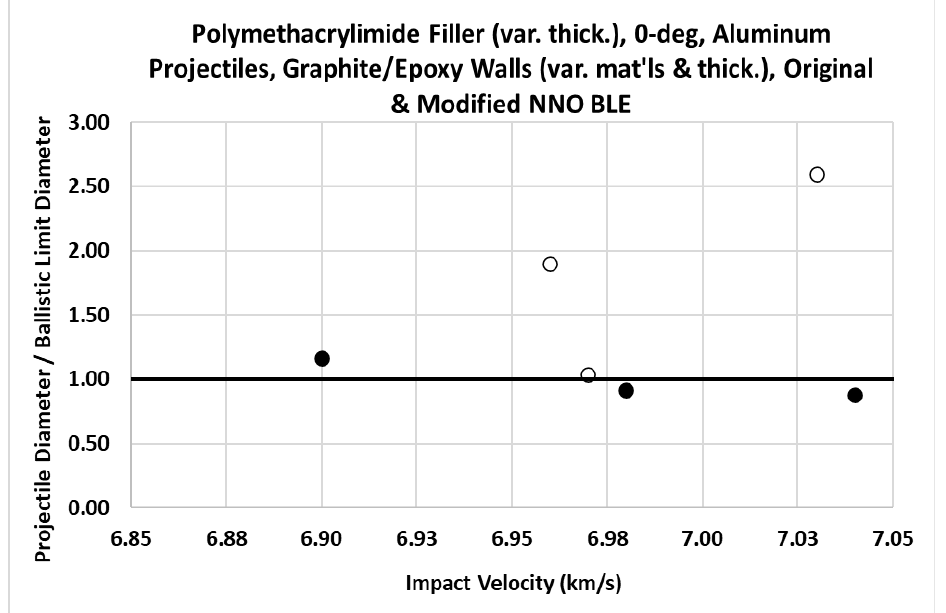
Figure 8. Comparison of Original and Modified NNO BLEs against P/NP data in [10,11] for Dual- Wall Systems with Non-Aluminum Walls and a Polymethacrylimide Filler.